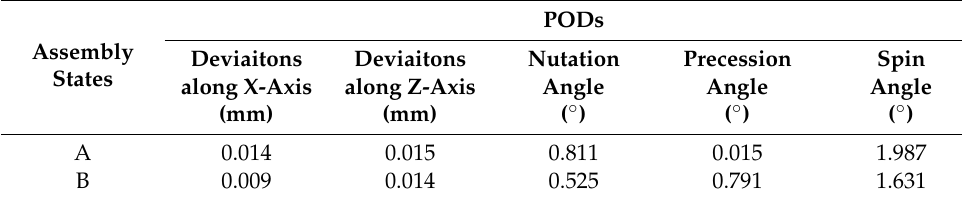
Table 5. Acquired position and orientation deviations (PODs) of the rectangular sliding guide.